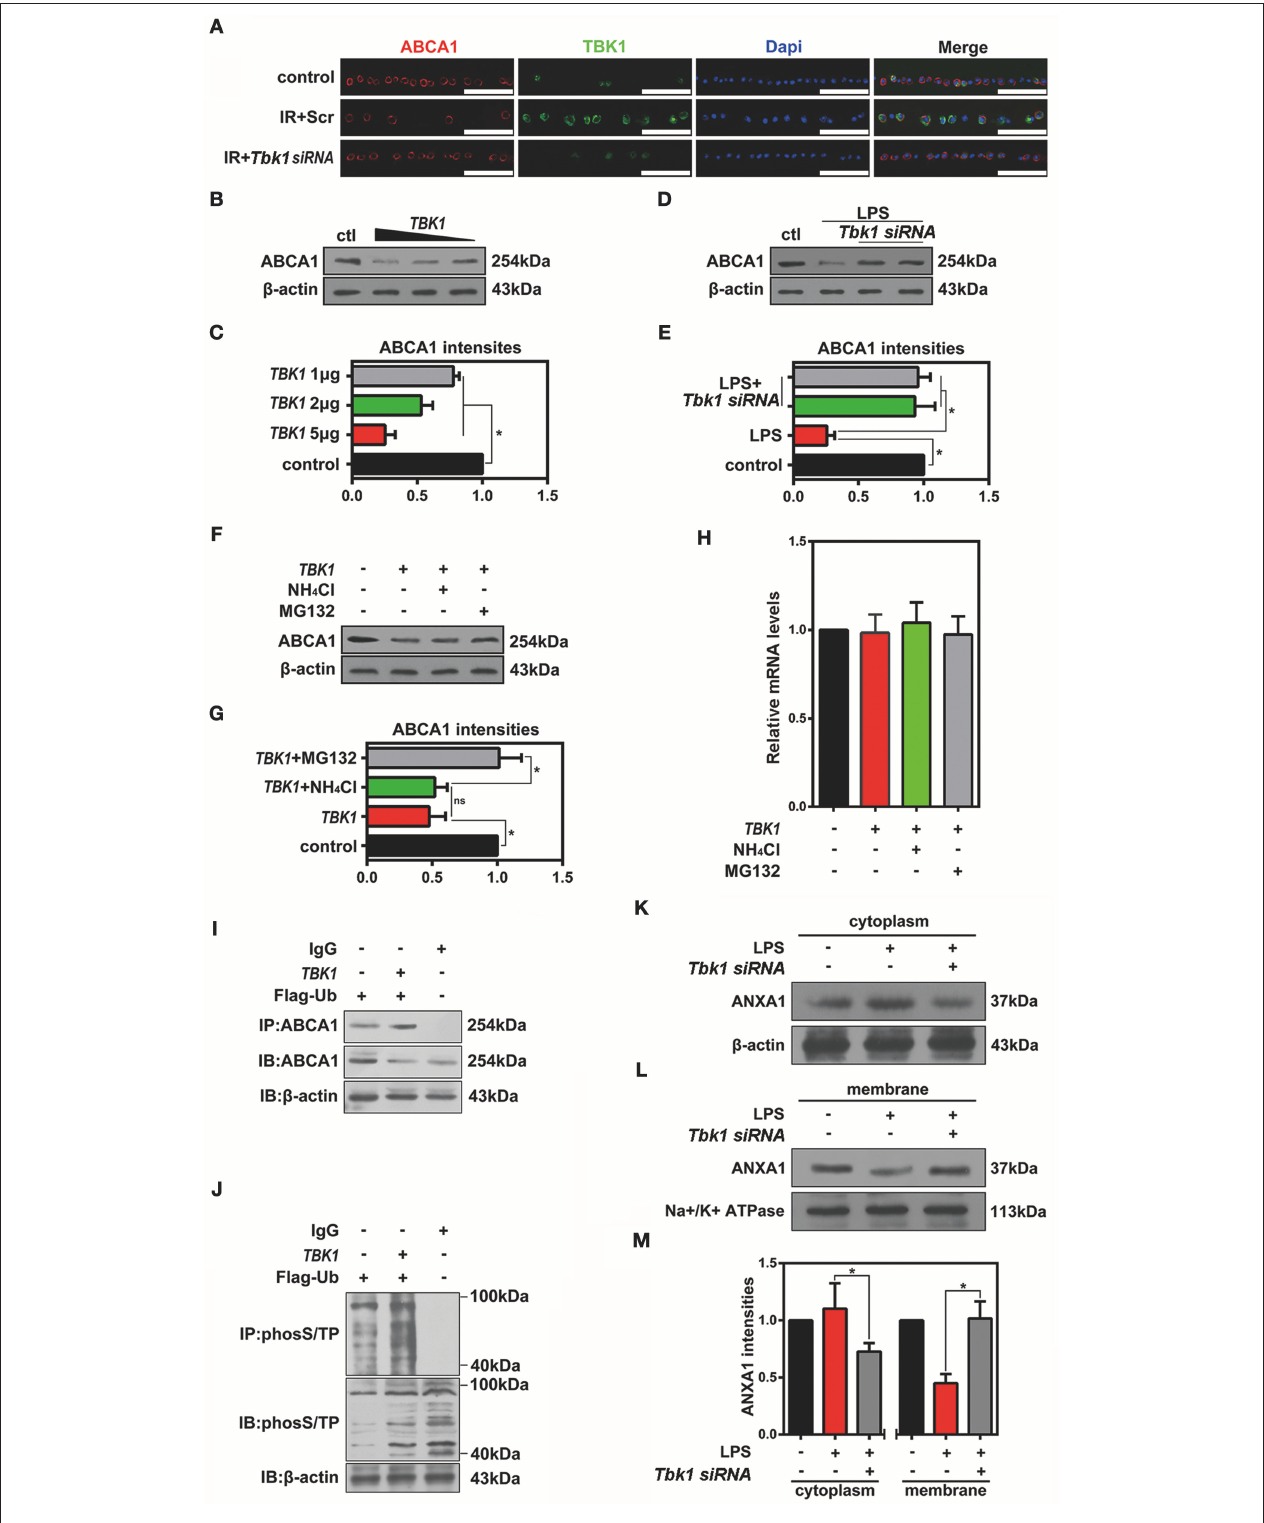
FIGURE 7 | The effects of TBK1 on ABCA1 expression and degradation. (A) Immunofluorescence results showing that TBK1 and ABCA1 can be co-localized and that Tbk1 siRNA knockdown increases the expression of ABCA1 in RGCs ( n = 6 retinas per group). Blue: DAPI; red: ABCA1; green: TBK1. Scr, Scrambled